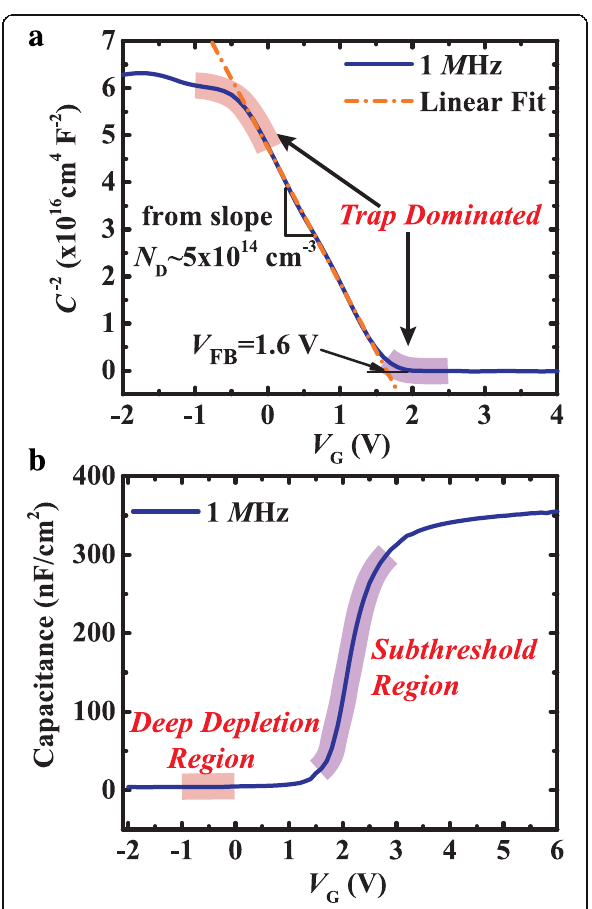
Fig. 2 a 1/ C 2 -V G characteristic on Al 2 O 3 /GaN MOS device measured at frequency of 1 MHz. The dashed dot line is the linear fitting of the linear part of the 1/ C 2 -V G curve and the deviation from the linear slope as highlighted in the curves suggesting trap-dominated regions. b Two trap-dominated regions highlighted in the C-V G curve and marked with deep depletion and subthreshold